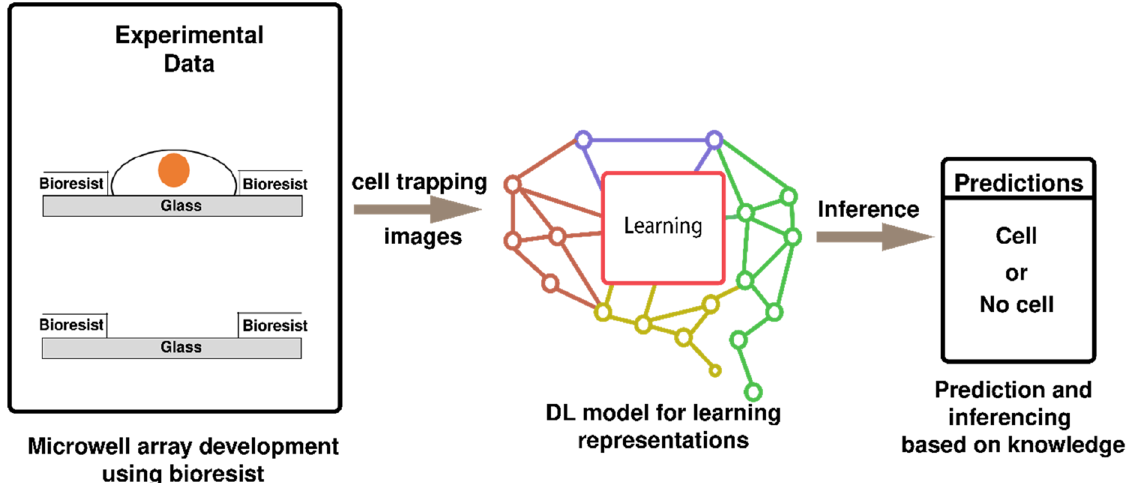
Figure 1. ( A ) schematic overview of the work reported in the paper. In the paper, we have demonstrated a novel method of developing microwell arrays using photo patternable bioresists. This enhances the biocompatibility of the developed microstructures. We captured images after seeding cells in microwells to observe cell trapping. We prepared a DL model that would learn important representations from those images, like microwell location and cell structure, etc., and would be able to detect the presence of single cells within a particular spin-coating. The wafer was baked on a hot plate (EC-1200 N, AS ONE, Japan) at 180 °C for 10 min to remove water molecules on the surface. Then, it was allowed to cool at room temperature for 5 min. HDMS (Hexam- ethyldisilazane, OAP, Tokyo Ohka Kogyo, Japan) was spin-coated at 500 rpm for 20 s and 3000 rpm for 60 s over the wafer with a spin-coater (1H-DX-2, Mikasa, Japan). The wafer was baked at 65 °C for 2 min, at 120 °C for 10 min, and at 65 °C for 2 min. It was brought to room temperature and kept for 5 min. Bioresist was spin-coated at 500 rpm for 20 s and 6000 rpm for 60 s over the wafer. The wafer was baked at